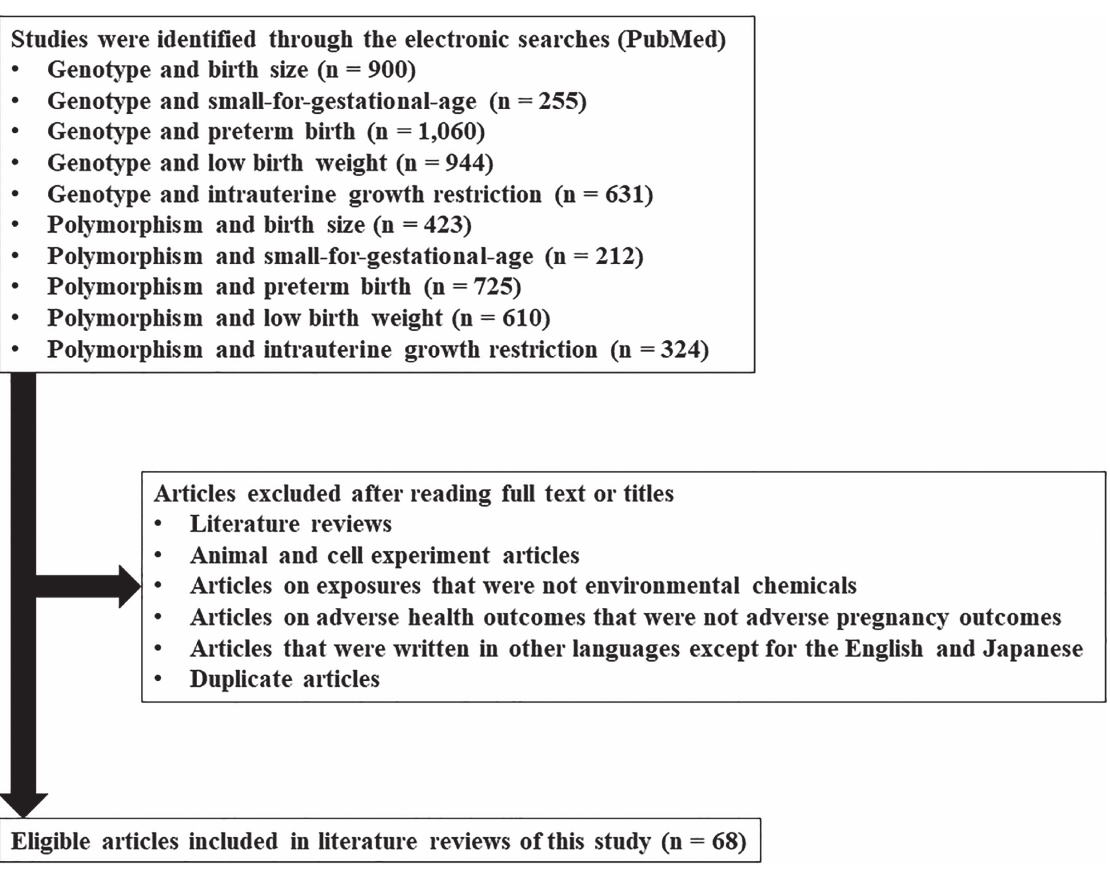
Fig. 1 Flow diagram of the study selection process for the literature